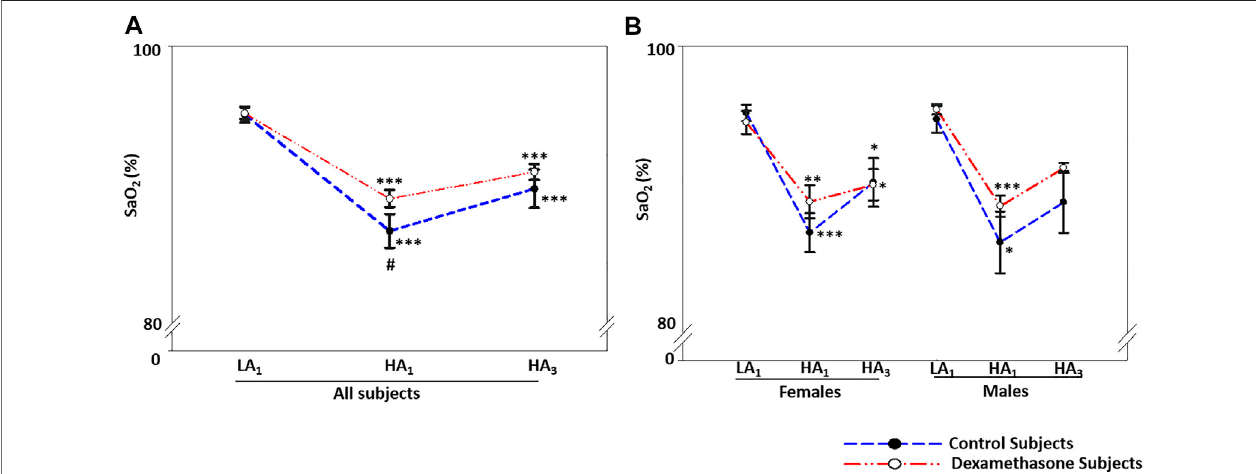
FIGURE4 | Dexamethasone-mediated SaO2-control at HAwas similar inboth thesexes. (A) Dexamethasoneameliorated SaO 2 by~1.7% compared tocontrols. (B) Dexamethasone showed a similar control of SaO 2 in both the sexes, that is, by ~1.7% in women and ~1.8% in men. Data are presented as mean ± SE and are comparedbyone-wayANOVA. * p < 0.05,** p < 0.01,and *** p < 0.001wereconsidered statistically signi fi cant.*representssigni fi cancewithineachgroup compared to respective control.